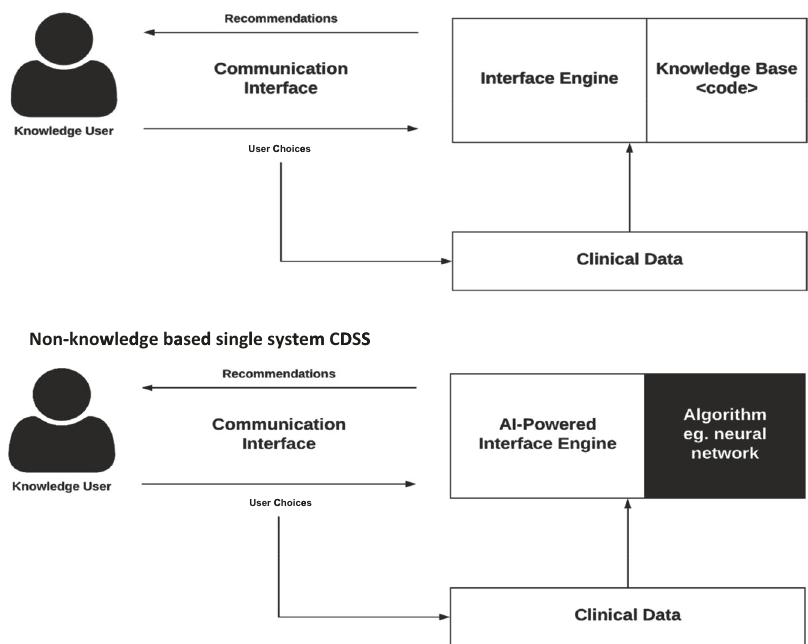
Fig. 1 Diagram of key interactions in knowledge-based and non-knowledge based CDSS. They are composed of (1) base: the rules that are programmed into the system (knowledge-based), the algorithm used to model the decision (non-knowledge based), as well as the data available, (2) inference engine: takes the programmed or AI-determined rules, and data structures, and applies them to the patient ’ s clinical data to generate an output or action, which is presented to the end user (eg. physician) through the (3) communication mechanism: the website, application, or EHR frontend interface, with which the end user interacts with the system 9